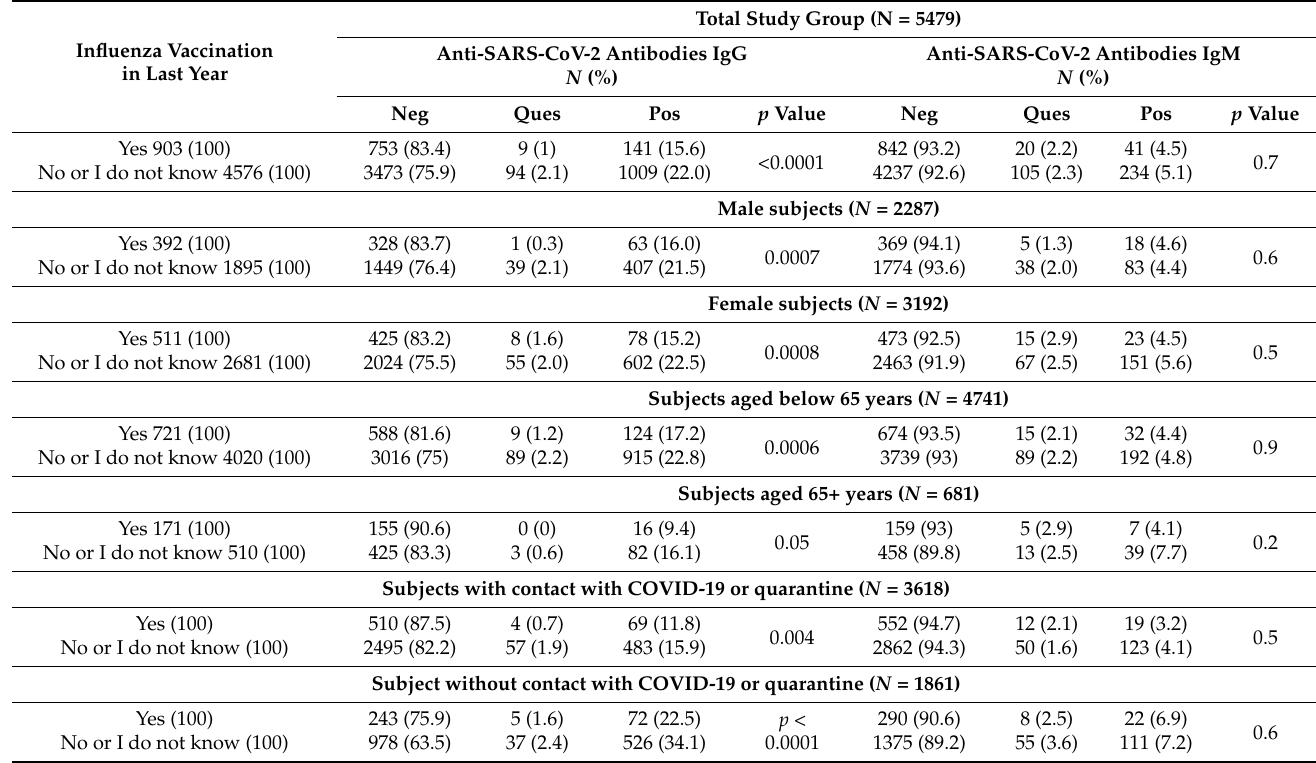
Table 2. Association between the SARS-CoV-2 serological status and influenza vaccinations in all subjects and their specific subgroups defined by sex and age and COVID-19-related history.